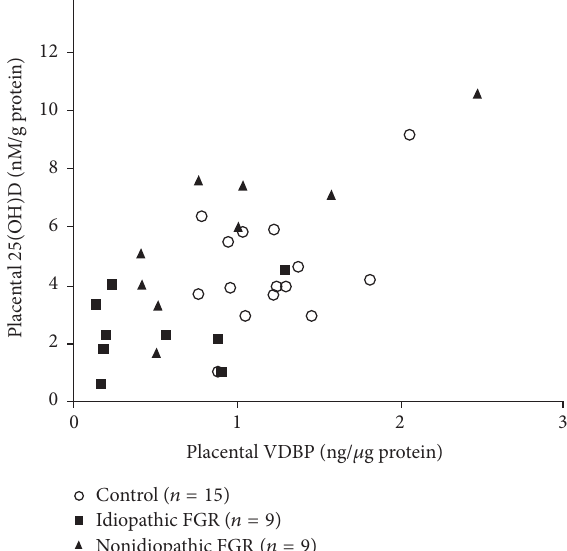
Figure 2: Relative VDBP and 25(OH) vitamin D concentrations do not significantly correlate, as measured in third-trimester placentae from control and FGR pregnancies, 𝑛 = 35 , 𝑝 = 0.295 , 𝑟 = 0.182 , Pearson’s correlation. Note . two extreme outliers from the control 25(OH) vitamin D group have been excluded from the